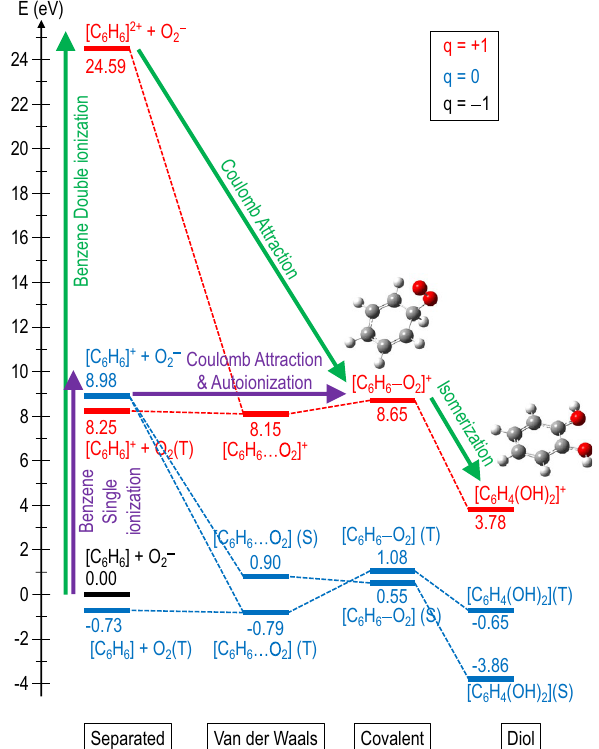
Figure 6. Different ways to produce neutral and positive charged benzene diols via O 2 − collisions with C 6 H 6 ; − Coulomb attraction to produce neutral diol configurations; ― , same ― , single benzene ionization plus O 2 process but producing an autoionizing state which decay to the benzene diol cation. ― , double benzene ionization plus Coulomb attraction leading to benzene diol cation